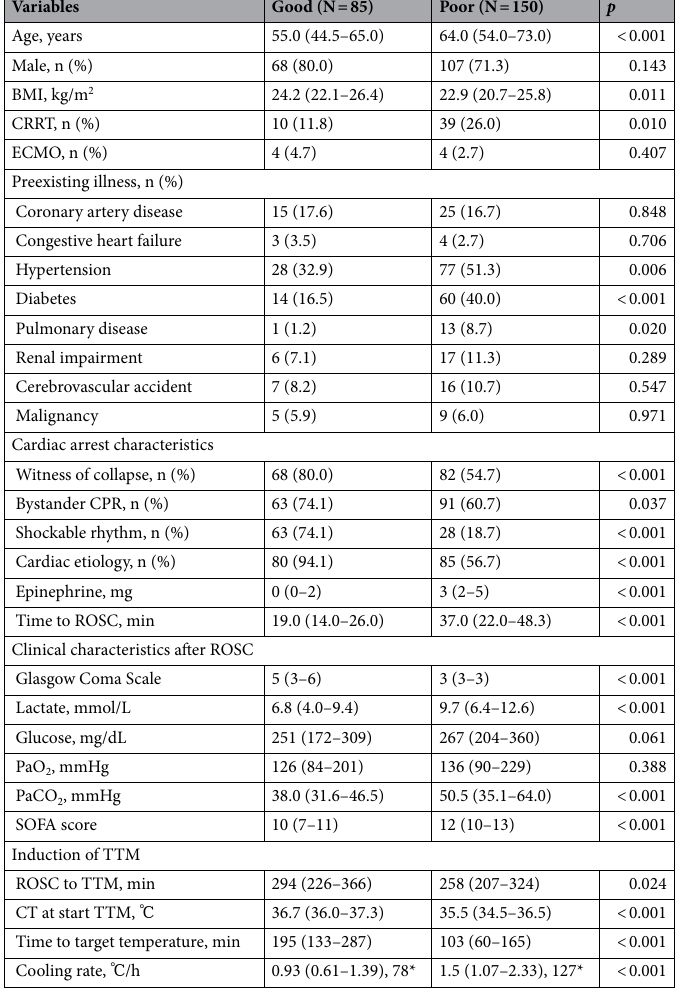
Table 3. Comparison of baseline characteristics according to the neurological outcomes at 6 months. Categorical variables were expressed as frequencies with percentages and continuous variables were expressed as medians with interquartile ranges. BMI body mass index, CRRT continuous renal replacement therapy, ECMO extracorporeal membrane oxygenation, CPR cardiopulmonary resuscitation, ROSC return of spontaneous circulation, SOFA sequential organ failure assessment, TTM targeted temperature management, CT core temperature. *included a number for analysis.